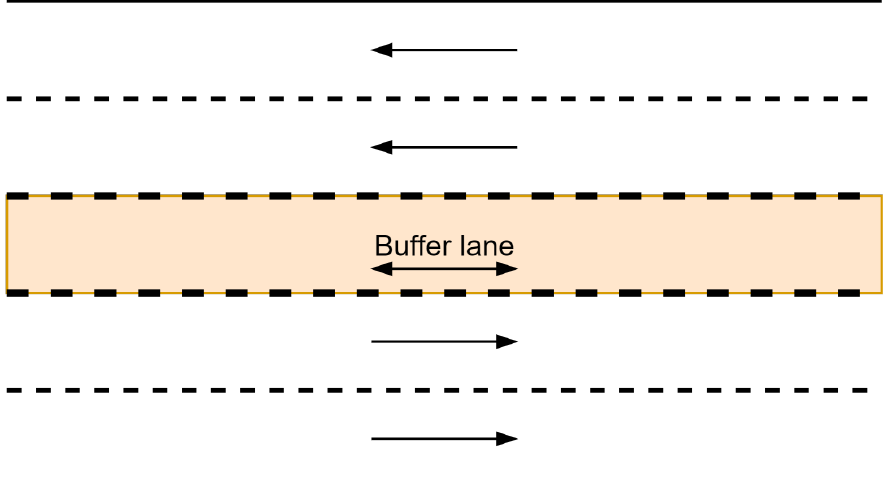
Figure 1. Bi-directional roadway with a central Buffer lane (orange) (inspired by